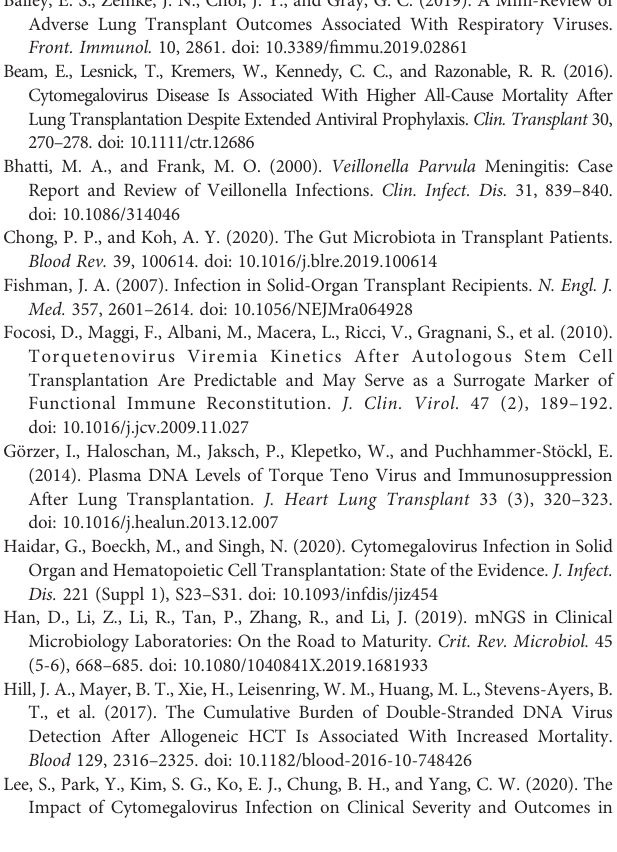
(B) lung microbiomein specieslevel; (C) Estimated speciesrichnesswas calculated as Shannon index, there were signi fi cant differences between virus and non-virus; (D) anosim analysis of lung microbiome; (E) nonmetric multidimensional scaling analysis revealed that the within-group variance is larger than the between- group variance.